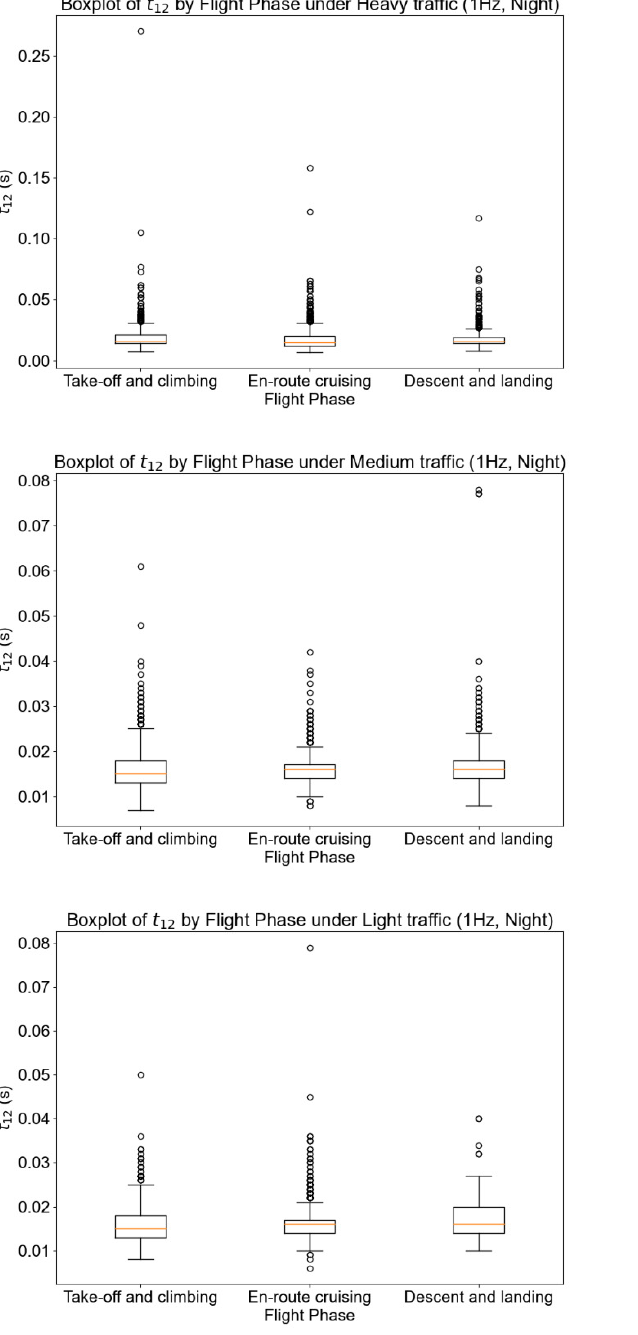
Figure A2. The boxplots of 𝑡 (cid:2869),(cid:2870) during night-time setting.